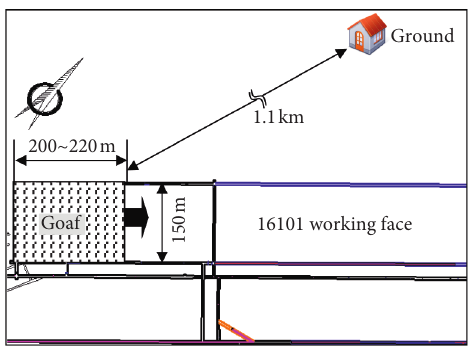
Figure 3: Intrusion and compression effects of magmatic rock in large faults.